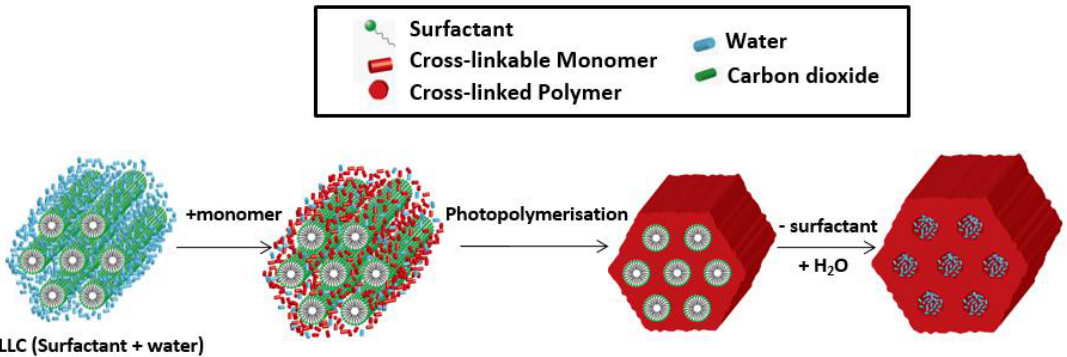
Figure 4. Template method from hexagonal lyotropic liquid crystals (LLCs) for the fabrication of mesoporous membranes. The hexagonal LLCs template is from Dodecyltrimethylammonium bromide (DTAB) and H 2 O [29] (Reprinted with permission from [29]. Copyright (2011) Royal Society of Chemistry).